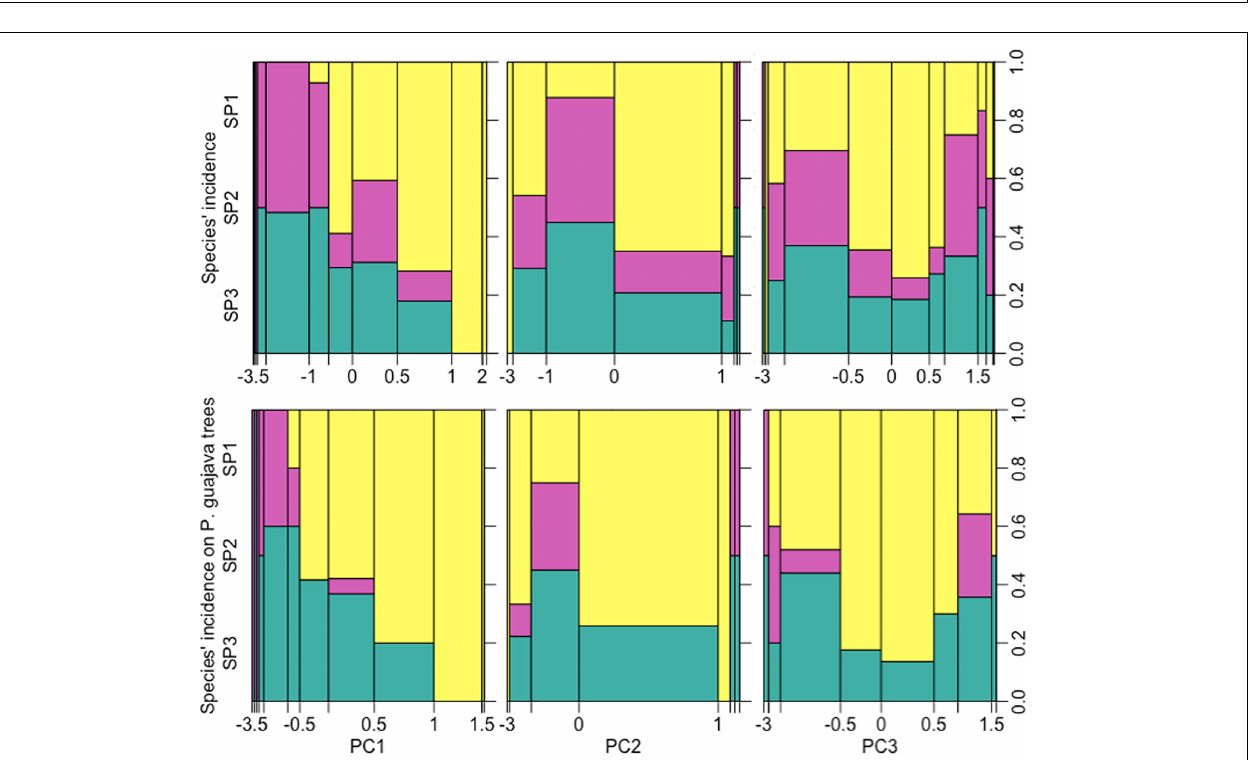
FIGURE 7 | Distribution of three species of Anastrepha from the fraterculus complex in Brazil. Points represent known localities and colors toward the green indicate higher probability of occurrence, according to the MaxEnt model which best discriminate presence localities from a random set of localities, based on 14 bioclimatic variables, taken from WorldClim 2.